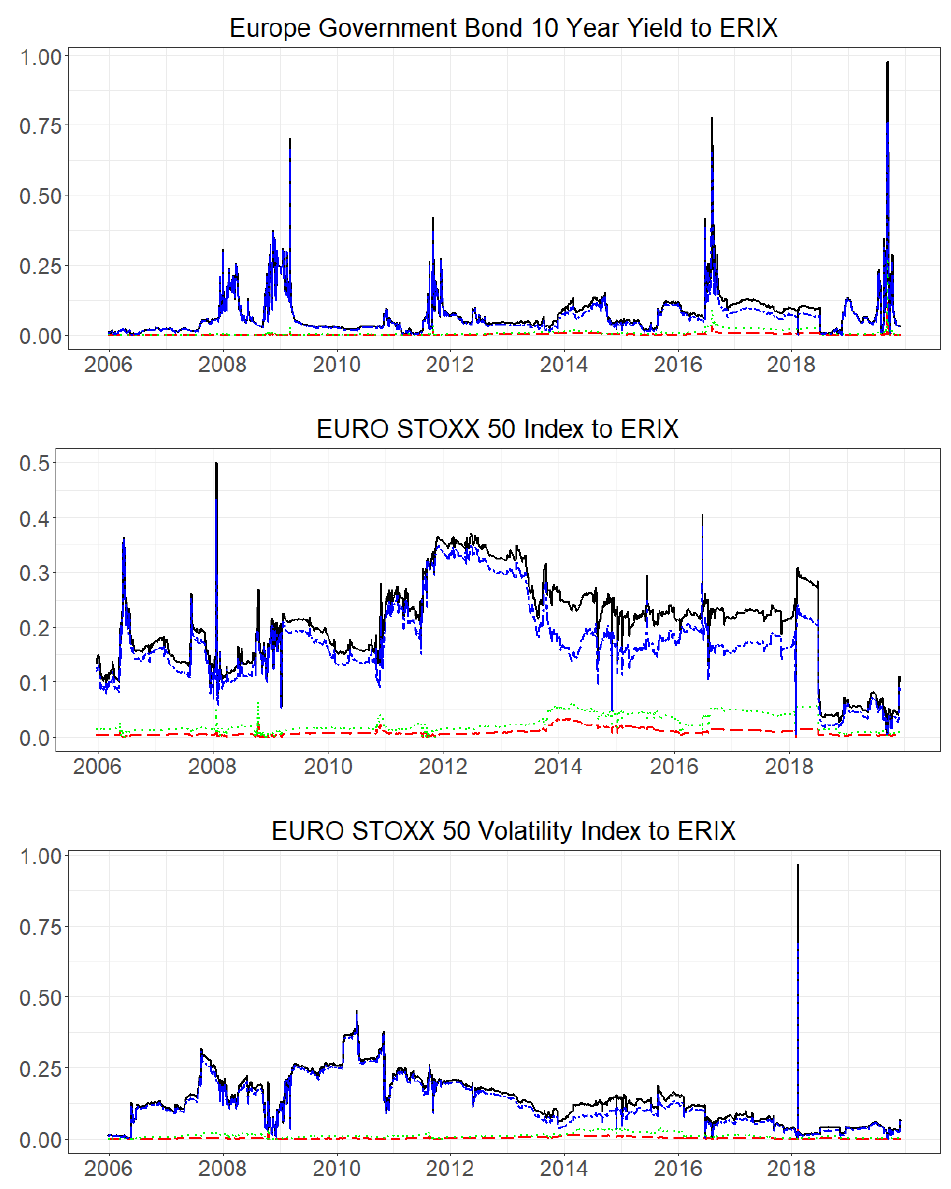
Figure 10. Diebold–Yilmaz [15] directional volatility spillover (pairwise) and Barunik–Krehlik [16] directional volatility spillover (pairwise) in Europe. Note: ERIX indicates European Renewable Energy Index.